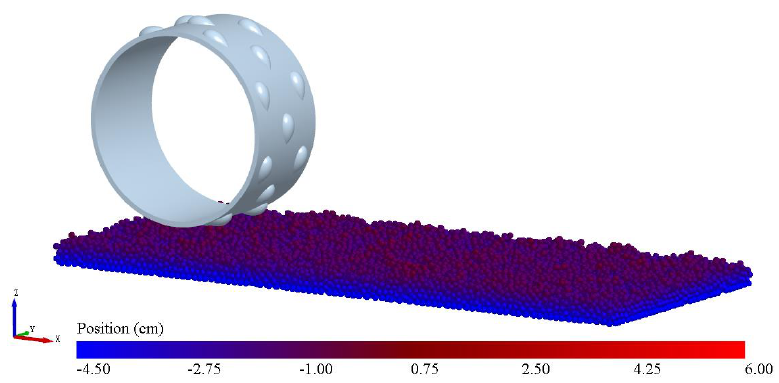
Figure 7. DEM model establishment and numerical